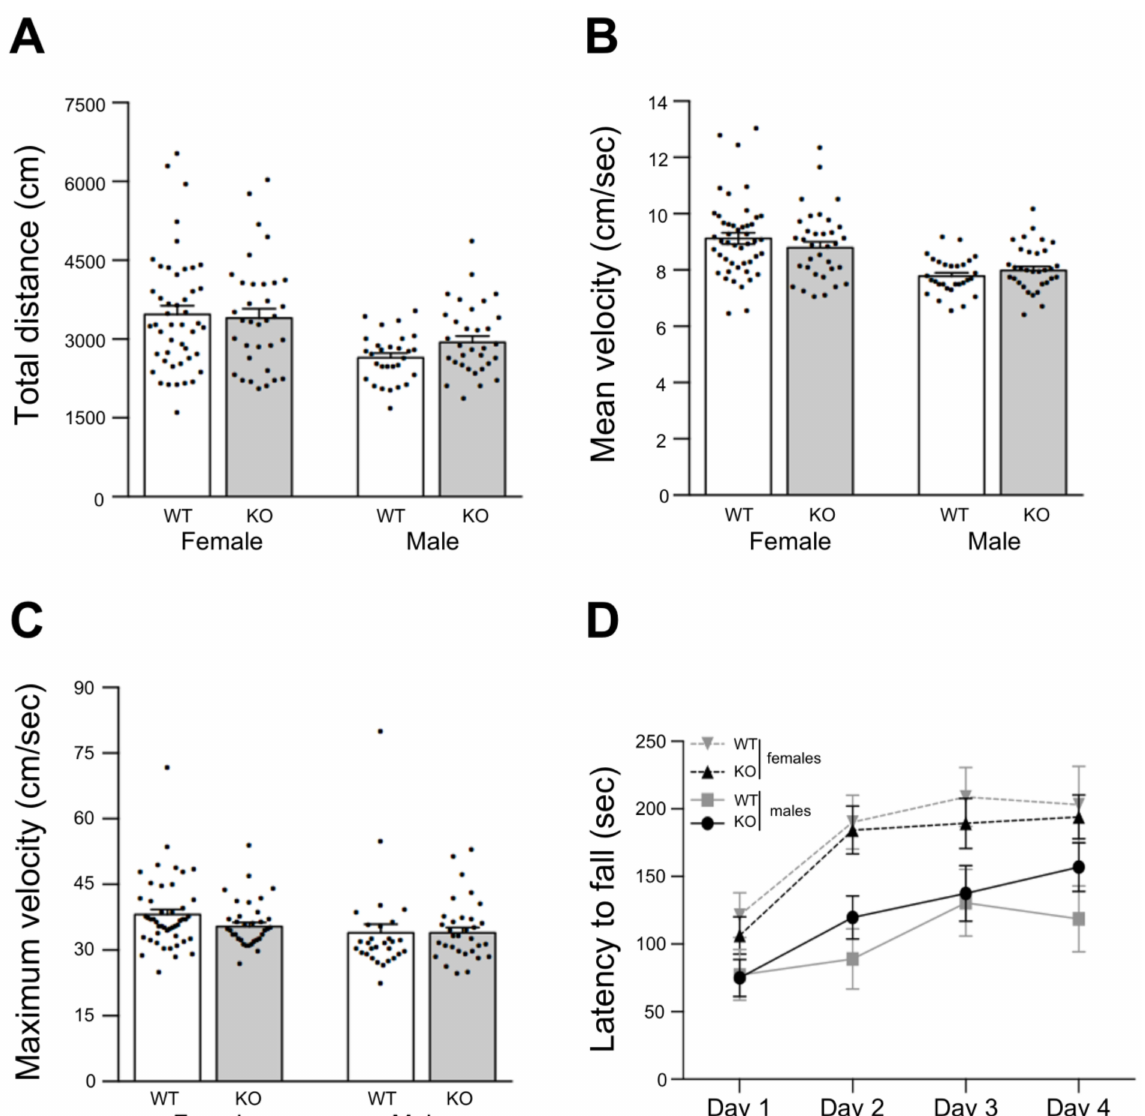
Figure 6. Spontaneous locomotion evaluated by the open field test. Total distance travelled ( A ), mean velocity ( B ) and maximum velocity ( C ) are displayed in bar graphs. Data are means + SEM (KO: n = 32 males, n = 34 females; WT: n = 29 males, n = 47 females). No differences between groups were observed according to two-way ANOVA followed by Tukey post hoc test. ( D ) Motor skill learning and motor performance evaluated by the rotarod test. The graph displays the time each animal takes to fall (latency) from an accelerating rotarod at different days after previous training. Data are mean latencies of three trials per day ± SEM. (KO: n = 5 males, n = 6 females; WT: n = 9 males, n = 12 females). Dots in bar graphs represent the measured value for each animal. No significant differences were detected between gender groups or mice strain groups according to two-way ANOVA with repeated measures followed by Bonferroni post hoc